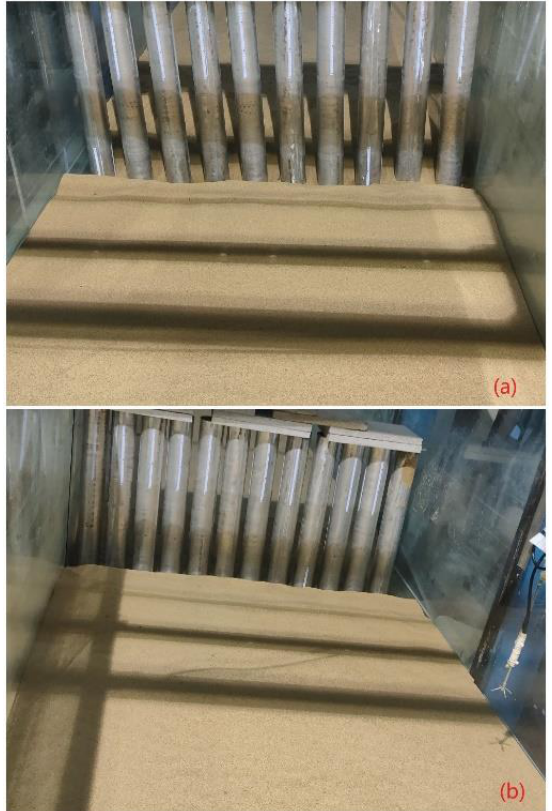
𝐷 𝑝 . Photographs of the experi-